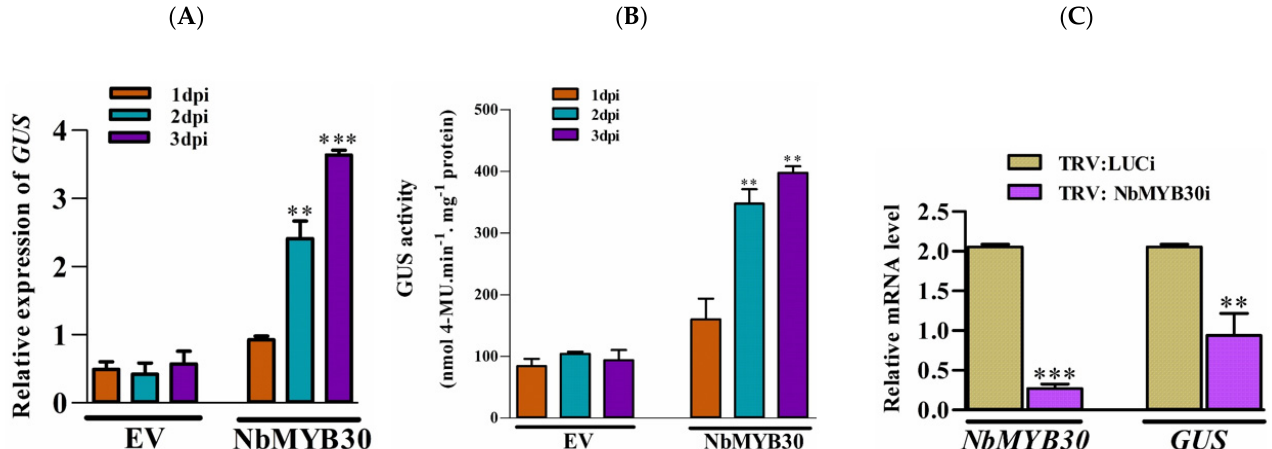
Figure 6. Effects of overexpression and silencing of NbMYB30 on GUS transcript levels in transgenic N. benthamiana plants. ( A ) The expression level of GUS was analyzed by real-time qRT-PCR, and ( B ) the activity level of GUS was analyzed by fluorimetric analysis. The transient expression effect of NbMYB30 significantly enhanced the GUS expression and activity level. ( C ) The TRV-based silencing of NbMYB30 significantly downregulated the transcript level GUS in transgenic N. benthamiana plants. Data are mean ± SD, * * p < 0.01, ** * p < 0.001 by Student t -test, respectively.